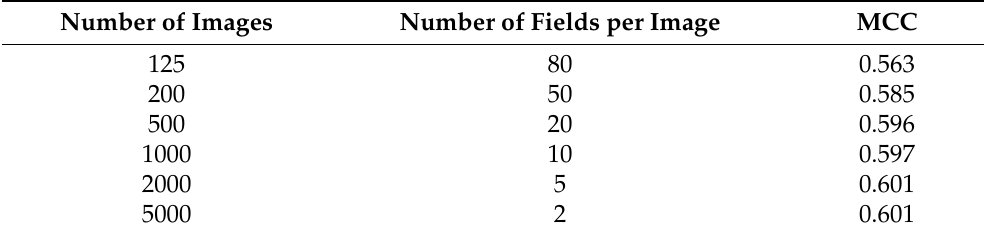
Table 2. Partial label experiment in France. We simulate a situation in France where we are con- strained to only collecting 10,000 field labels to answer whether it is better to collect full labels for a few images or partial labels for many images. We vary the number of images from 125 to 5000 and the number of fields per image from 80 to 2, while keeping the total number of labeled fields constant at 10,000. The evaluation metric is the Matthews Correlation Coefficient (MCC).